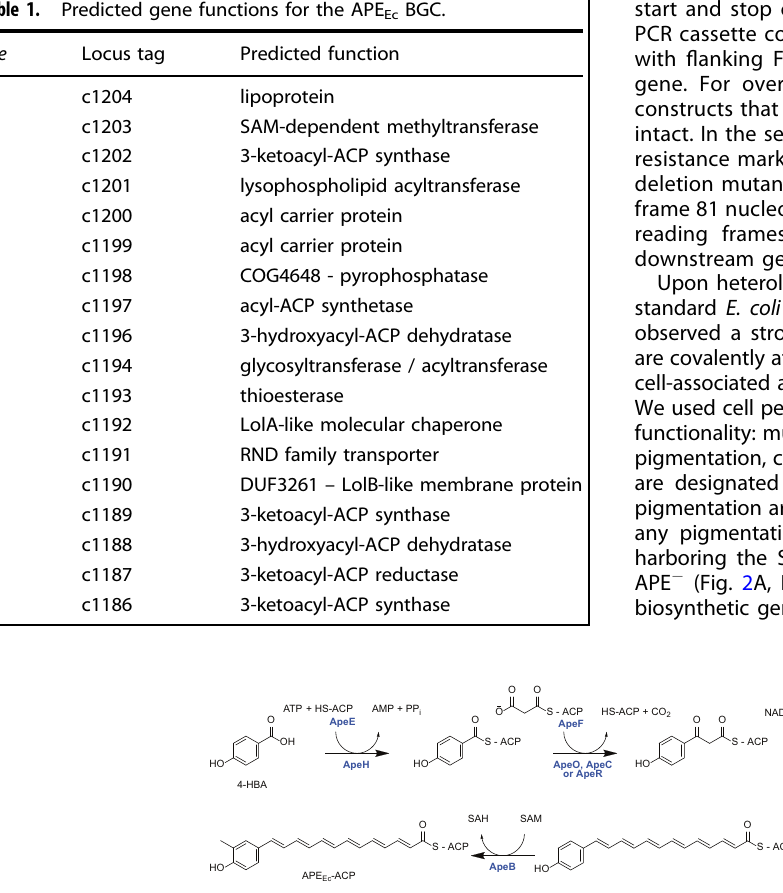
Fig. 3 Proposed pathway for APE Ec carboxylic acid biosynthesis. APE Ec biosynthesis is predicted to start with the ACP-activation of 4- hydroxybenzoic acid (4-HBA), an early intermediate in ubiquinone biosynthesis. The aromatic starter is further elongated with malonyl-ACP units (potentially carried by ApeF, ApeE, or the ACP involved in fatty acid biosynthesis, AcpP 30 ) by the repetitive action of fatty-acid-like type II polyketide biosynthetic enzymes: ketosynthase ApeO and ketosynthase-chain length factor ApeC, ketoreductase ApeQ, and dehydratases ApeI and/or ApeP. The SAM-dependent methyltransferase ApeB is involved in methylation of the aromatic head group, and it remains to be determined whether this modi fi cation occurs before or after ApeK (thioesterase) mediates release of the APE Ec -carboxylic acid from its ACP. The involvement of core enzymes in the pathway is indicated for E. coli CFT073 (in blue). SAM S-adenosyl-L-methionine, SAH S-adenosyl-L-